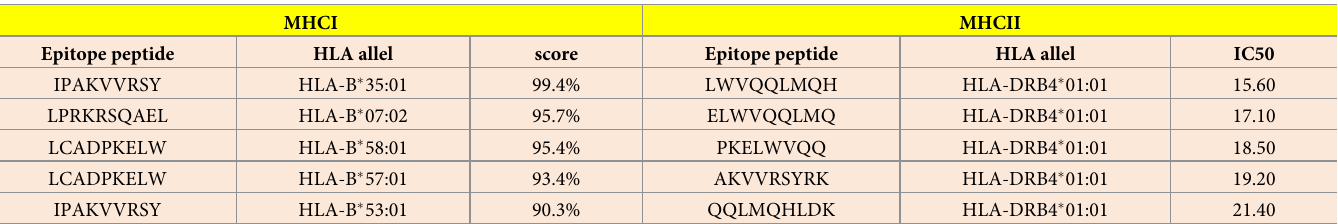
Table 1. Prediction of T-cell epitopes of CCL21/IL1 β protein. A covering score over 90% and IC50 below 50 were used for selecting the best binder epitopes of MHCI and MHCII-related